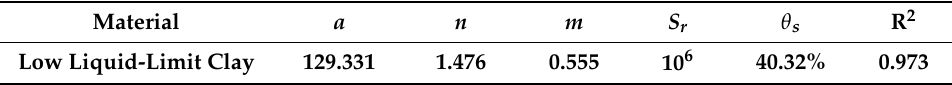
Table 3. Fitting results of soil water characteristic curve.